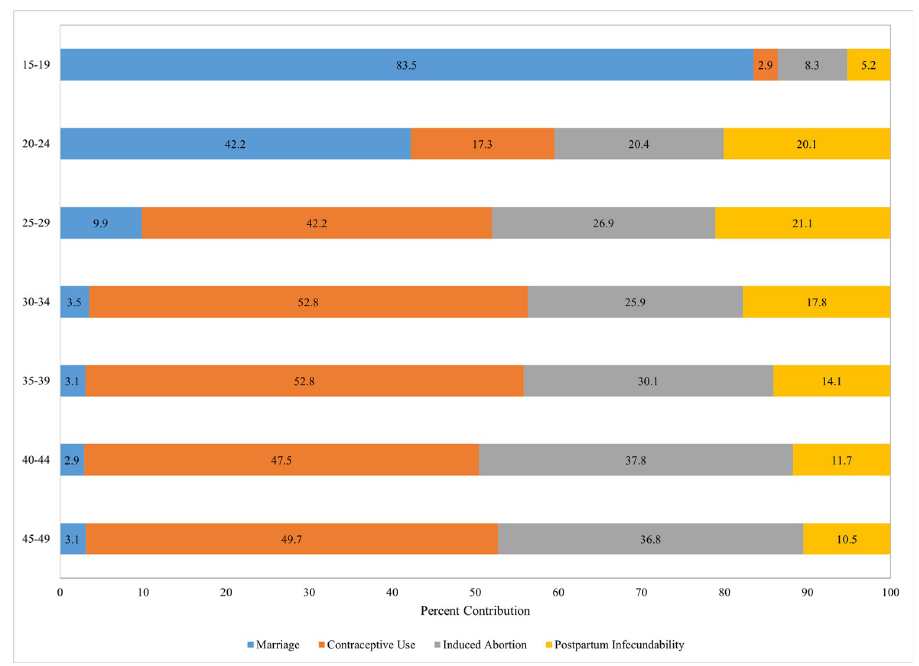
Fig 2. Contraception and abortion are the leading fertility inhibiting factors among women above age 25, India,